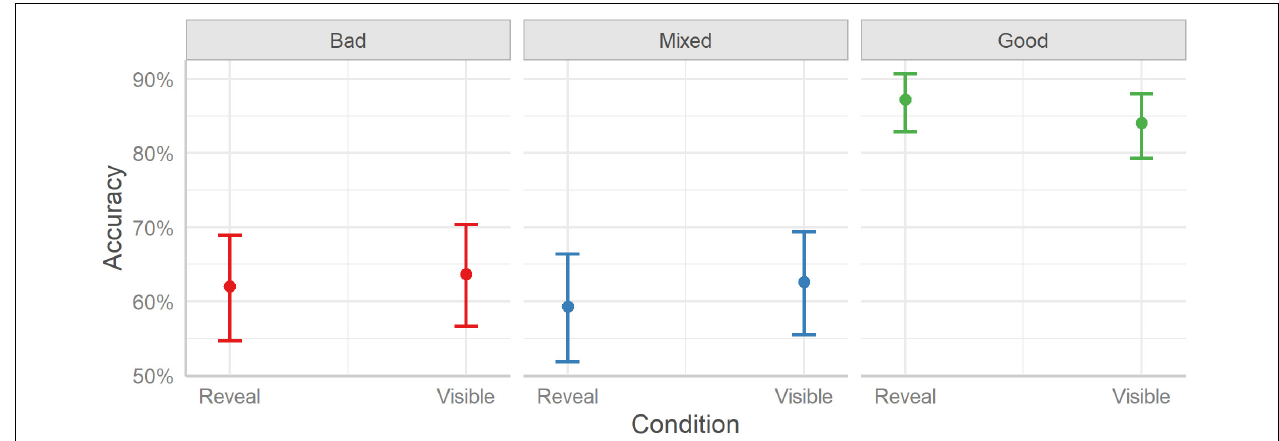
FIGURE 3 | User accuracy in categorizing a profile as bad, mixed, or good in the two experimental conditions (Reveal and Visible) split over the three Profile conditions (Bad, Mixed, and Good). Error bars indicate 95% credible intervals.